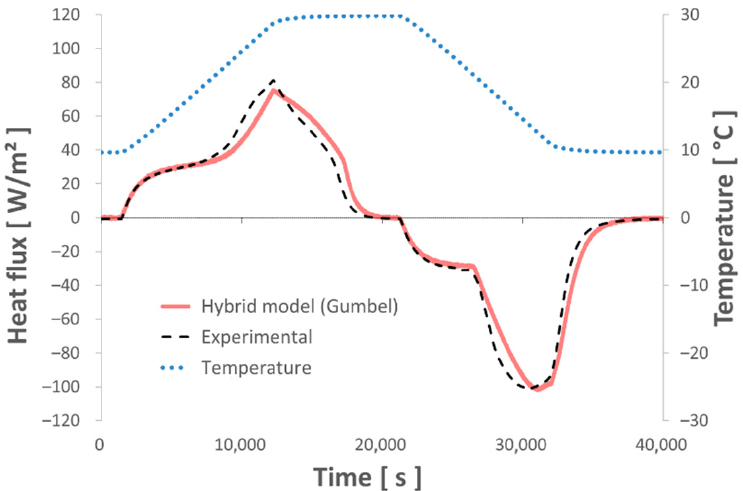
Figure 14. Evolution of the flux exchanged between the plate and the sample (3-h ramp).